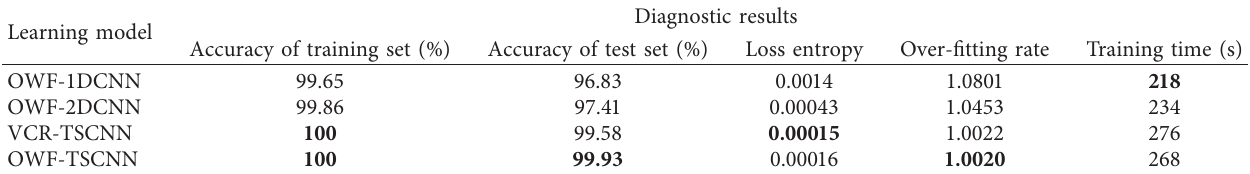
Figure 8: Accuracy and loss entropy: (a) accuracy of the training set; (b) accuracy of the test set; (c) loss entropy of the training set; (d) loss entropy of the test set. Table 8: Comparison of different diagnostic